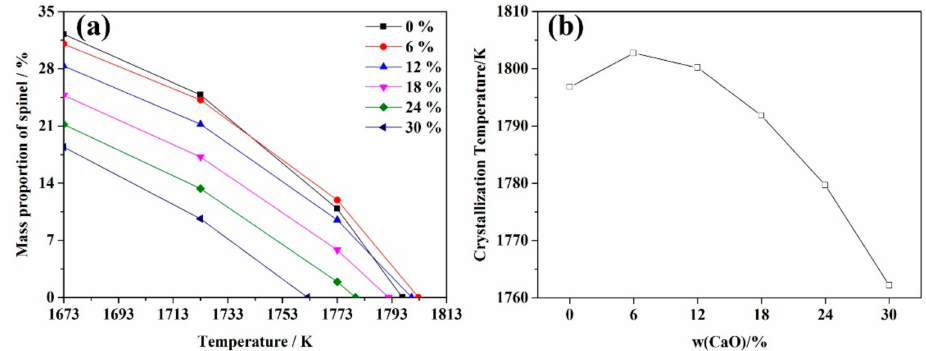
Figure 6. Effects of CaO content on the ( a ) mass proportion of spinel phase above 1673 K and ( b ) crystallization temperature of spinel